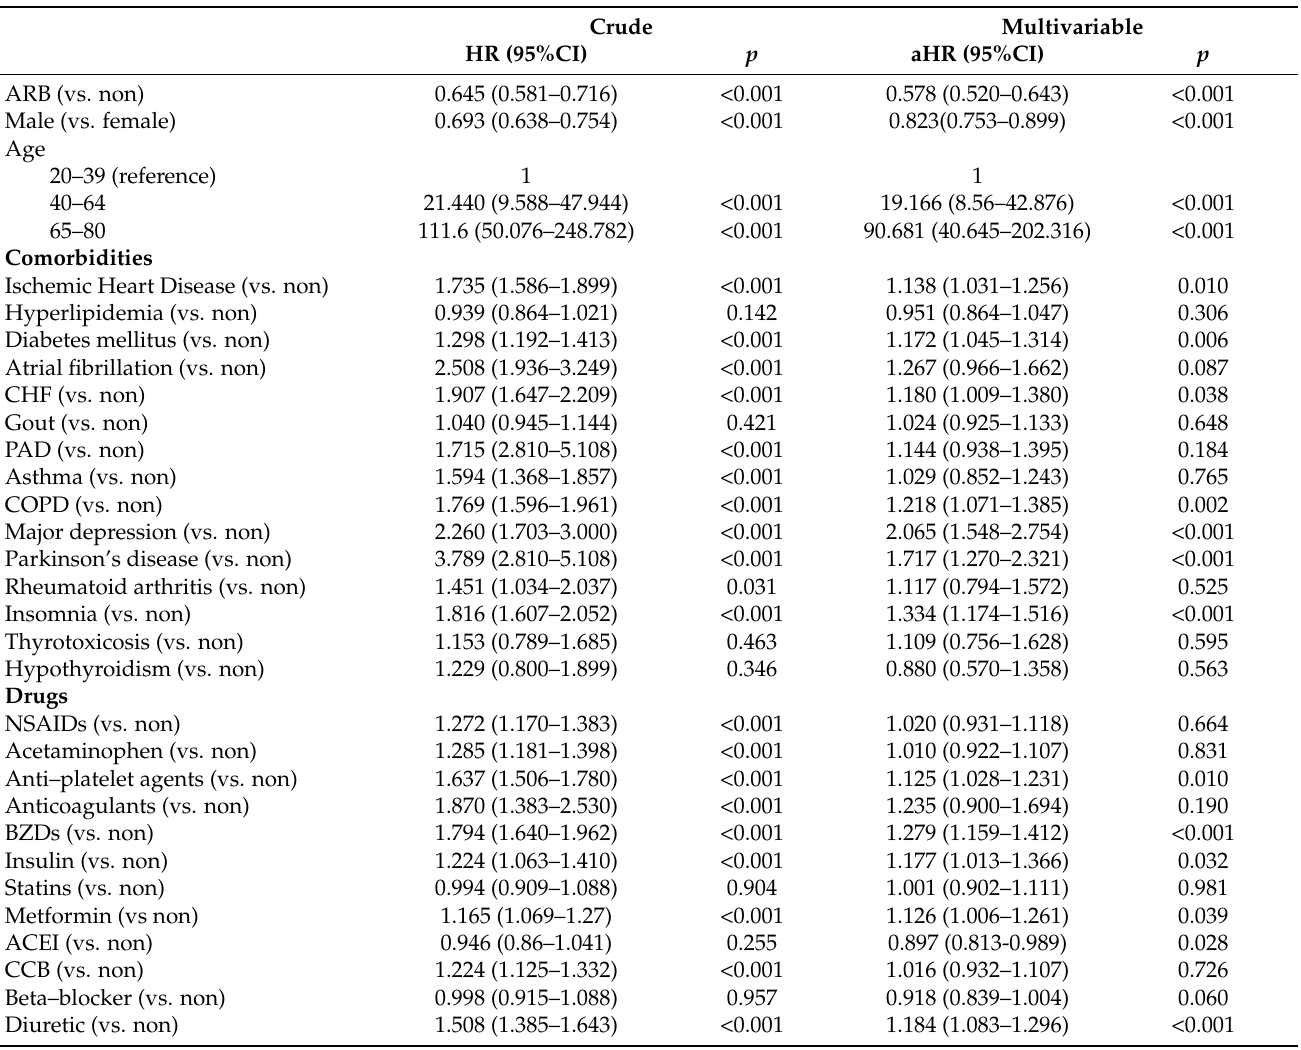
Table 2. Risk for developing dementia by using Cox competing risk